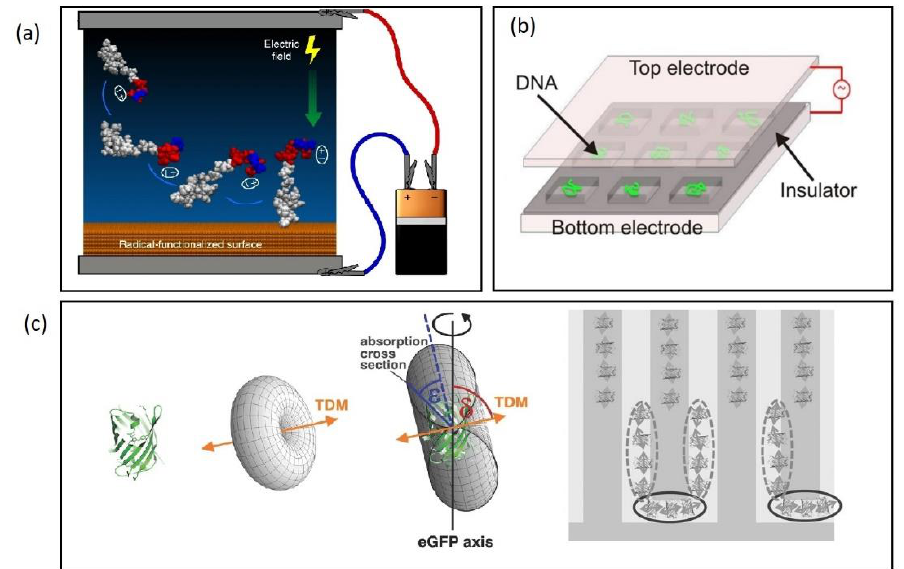
Figure 8. ( a ) Electric fields to control the orientation of peptides bonded to surfaces. Reproduced under terms of the CC-BY license Ref. [122] 2018, Martin et al., published by Nature publishing. ( b ) AC stretching of DNA in top-bottom electrode set-up. Reproduced under terms of the CC-BY license Ref. [126] 2018, Martin et al., published by Nature publishing. ( c ) Aligned immobilization of GFP onto an IDE electrode. Reproduced with permission [100] 2016, Wiley.